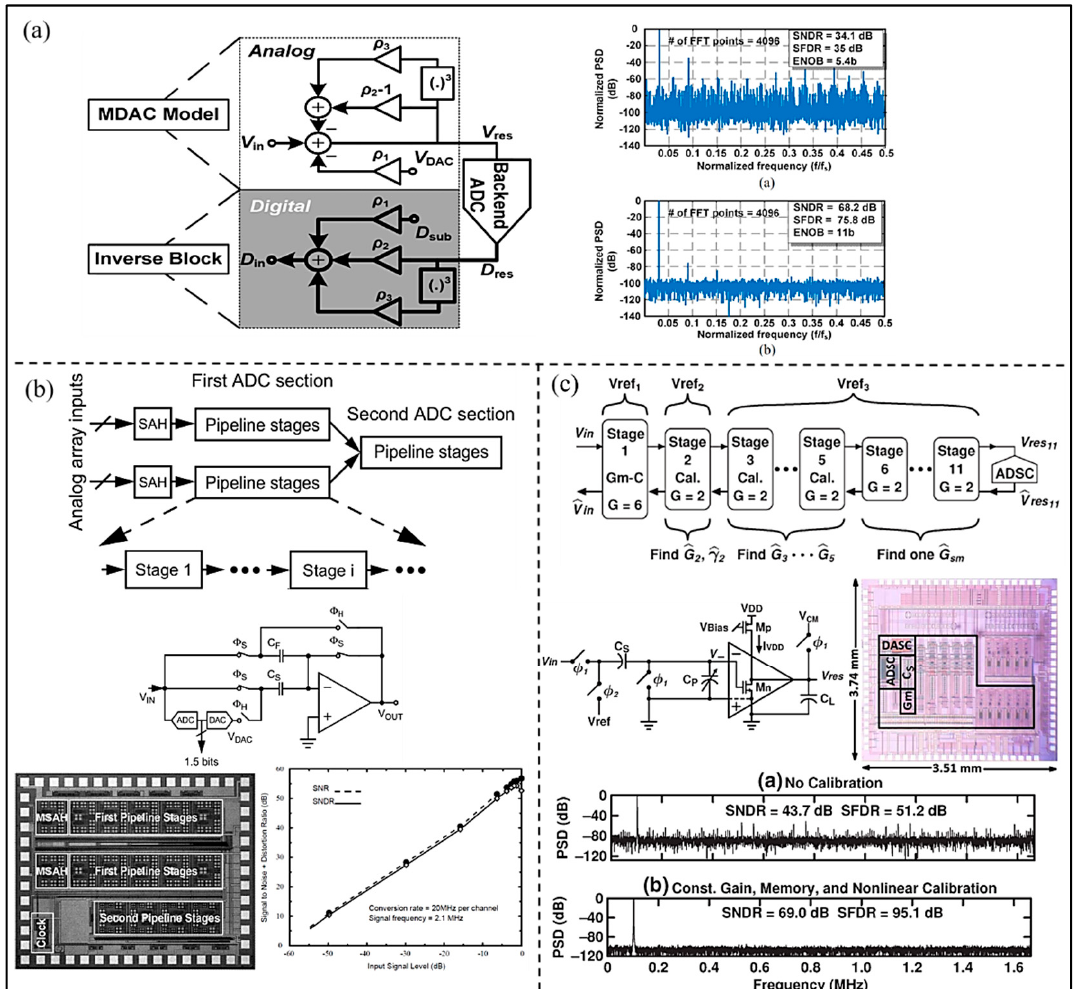
Figure 13. ( a ) Calibration procedure and simulated ADC output spectrum. (Reprinted from [55], Copyright 2017, with permission from IEEE); ( b ) Architecture and die photo of the proposed ADC and measured result. (Reprinted from [56], Copyright 2003, with permission from IEEE); ( c ) Block diagram of the prototype, schematic of a gm-C-based RA, the output spectra of the developed ADC, and die photo. (Reprinted from [57], Copyright 2015, with permission from IEEE).